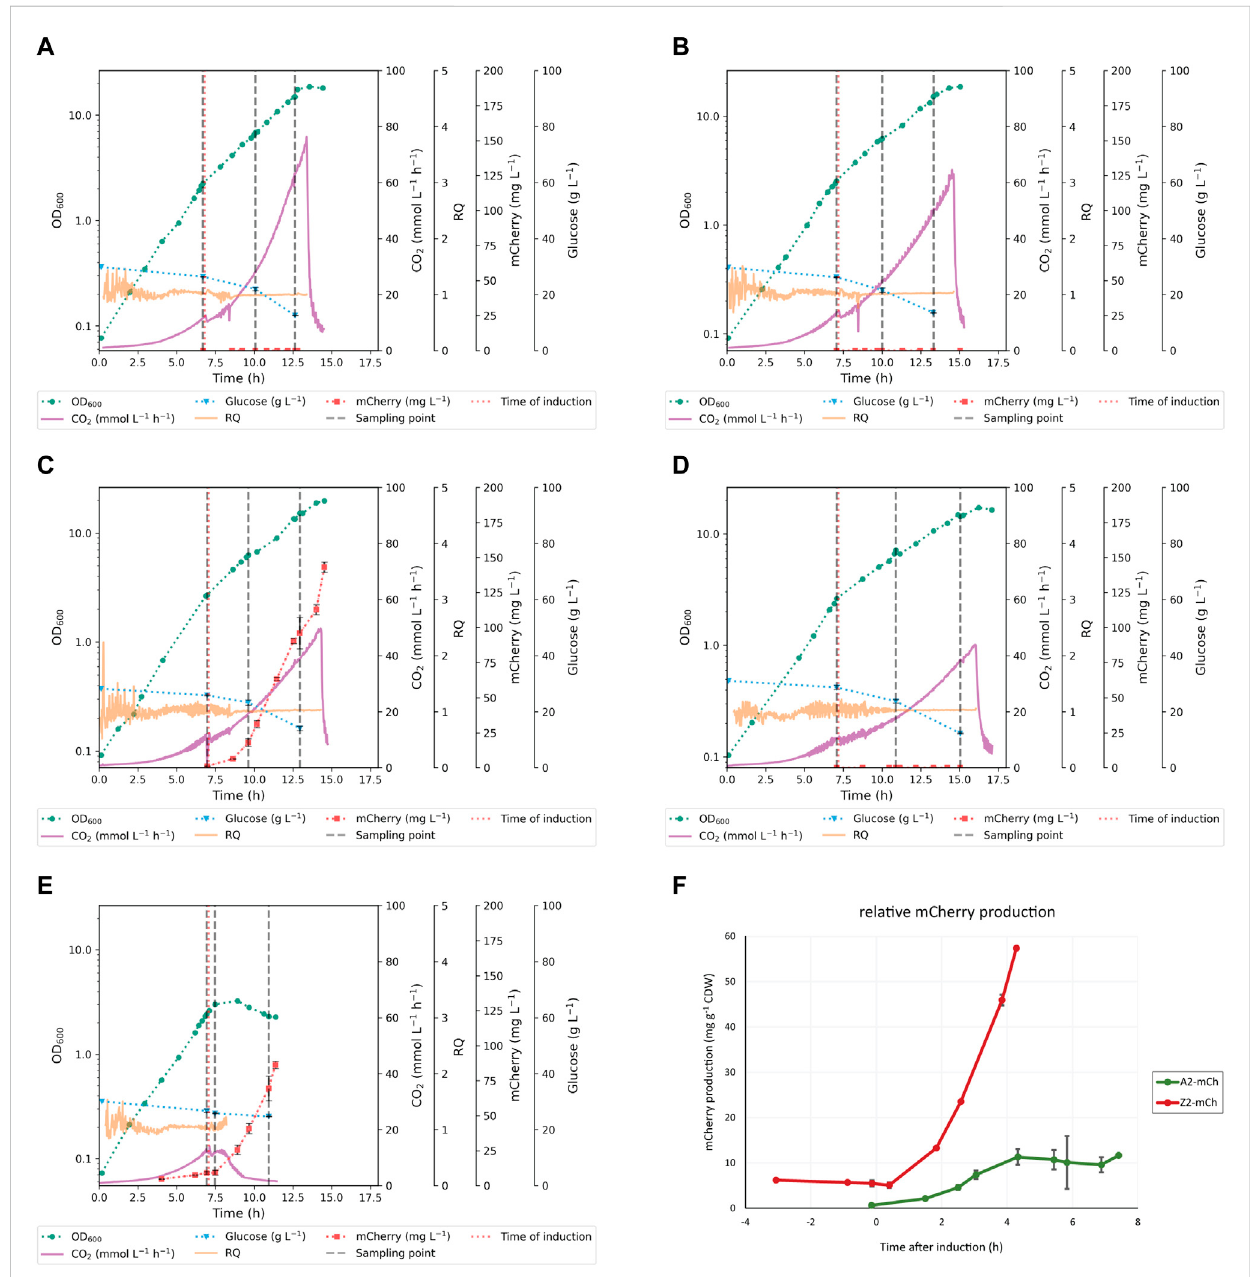
FIGURE 2 Growth and protein production pro fi les of the strains in benchtop bioreactors, including online and of fl ine cultivation data. The fi gure shows representative cultivations for each strain (A) WT Escherichia coli BL21 (B) Escherichia coli A2 (C) Escherichia coli A2-mCh (D) Escherichia coli Z2, and (E) Escherichia coli Z2-mCh. Indicated in the fi gure are biomass growth curves (OD 600 ), off-gas CO 2 production (mmol L -1 h -1 ), respiratory quotient (RQ), extracellular glucose concentration (g L -1 ), and absolute protein production (mg mCherry mL -1 ) for each time point. Error bars indicate standard deviations(SD).Inductionpointsaremarkedwitharedverticaldottedline;thethreeconsecutivesamplingpointsforthetargetedmetabolitepro fi lingare shownwithgreyvertical dashedlines (F) Comparison ofproteinproductionpro fi lesperbiomass(mg mCherryg -1 CDW) forrecombinantstrainsA2-mCh and